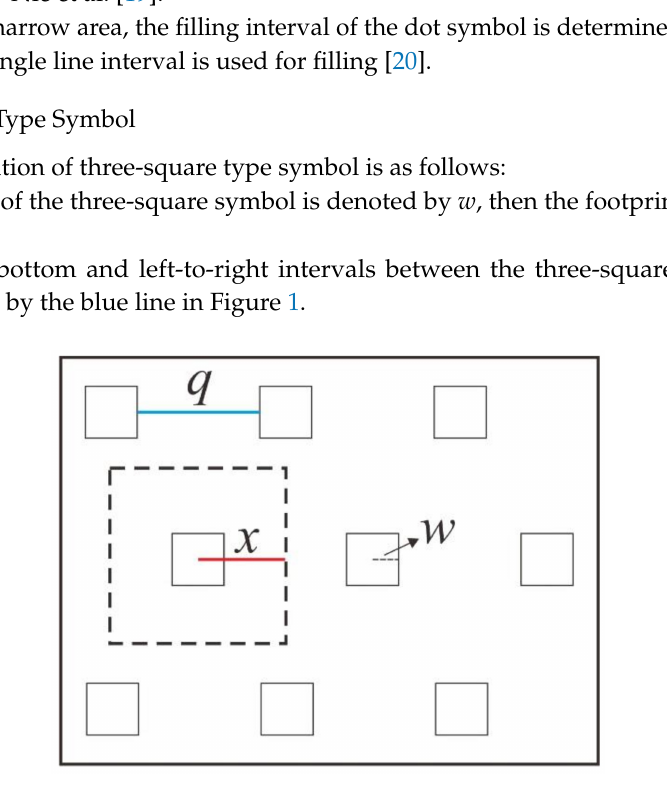
Figure 1. Schematics of three-square shaped